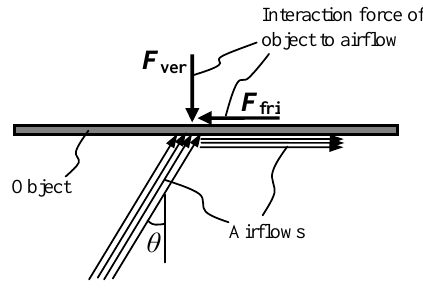
Fig. 5. Interaction between a planar object and